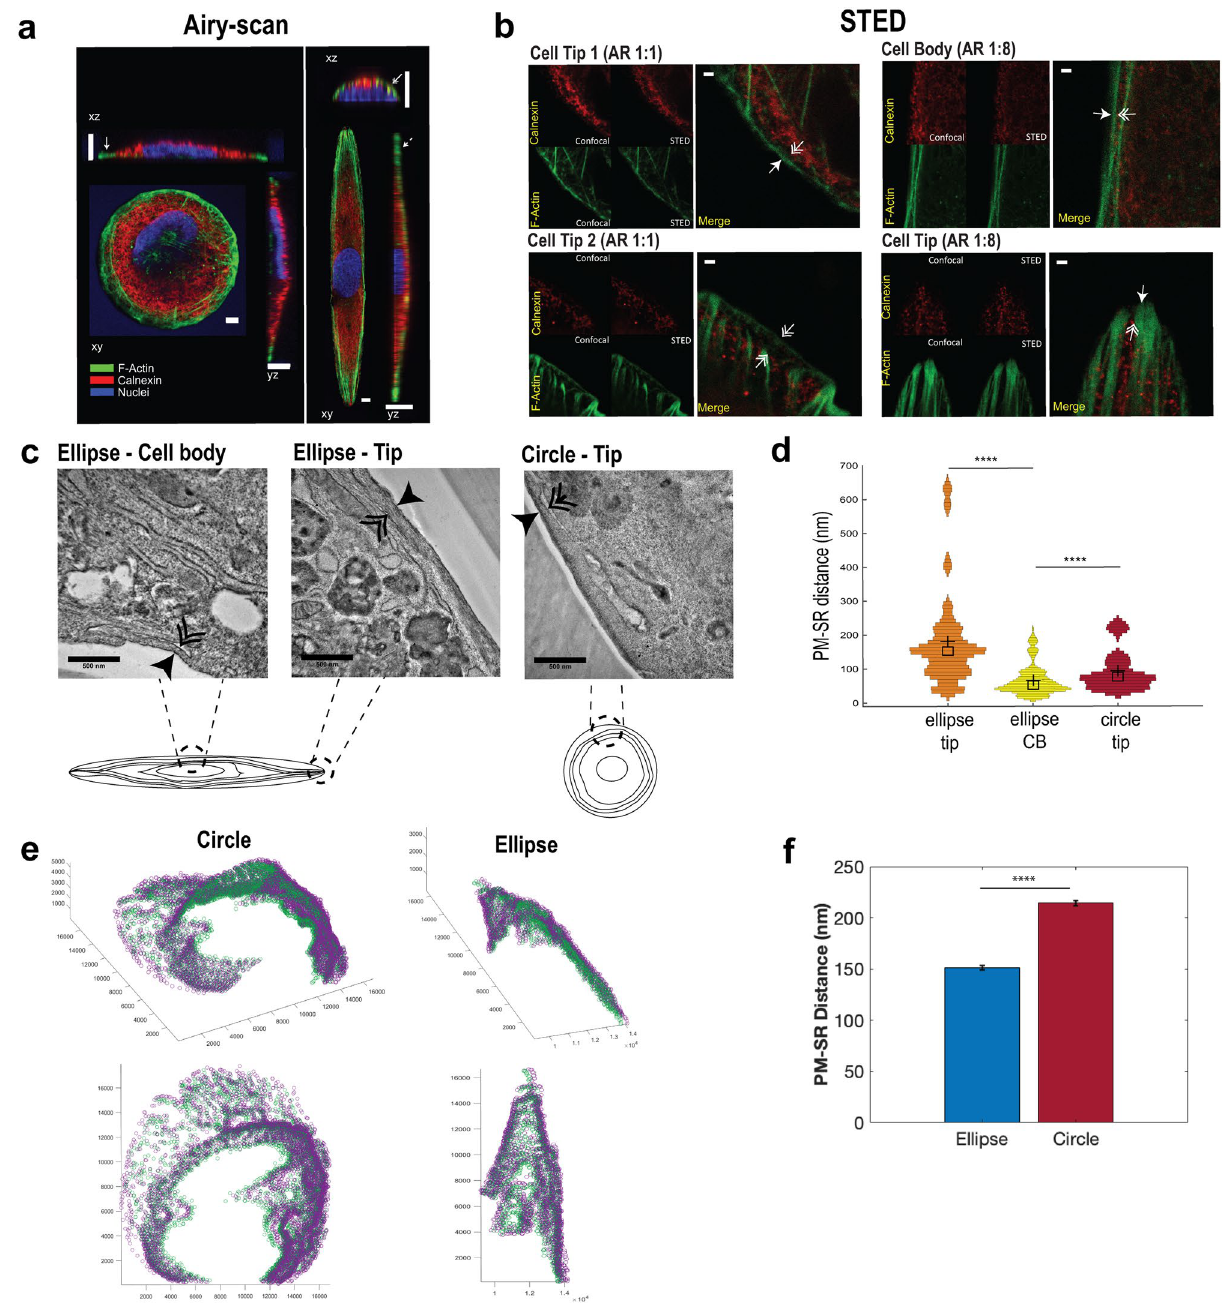
Figure 4. Shape impacts PM–SR distances in 3D. ( a ) (Left panel) 3D confocal volume scans of VSMC cultured in circle and ellipse (Aspect ratio of 1:8) patterns showing F-Actin (green), ER membrane marker calnexin (red) and nuclei (blue). Increased co-localization of red and green pixels are seen in the xz (short axis) cross-section of elliptical cells (solid double arrow heads), while little co-localization is evident in tips of both circular and elliptical cells (solid single-arrow heads and dashed single-arrow heads, respectively). Scale bars shown are 10 µm. ( b ) (Right panel) Super-resolution STED imaging of F-actin (green), calnexin (red), in cell tips of circular cells (AR 1:1) and in cell tip and cell body of elliptical cells (AR 1:8). Scale bars shown are 1 µm. ( c ) Representative TEM micrographs sampled from corresponding regions in micropatterned cells (cartoon). Single-headed arrows indicate the plasma membrane and double-arrows indicate smooth, peripheral SR, apposed to the plasma membrane. Scale bars shown are 500 nm. ( d ) Distribution plots of PM–SR distances obtained from TEM images, mean and median are shown as crosses and squares respectively. ( N ellipse tip = 329, N cell body = 254, N circle tip = 115, **** p < 0.0001, two-tailed Mann–Whitney test). ( e ) In order to quantify the 3D distribution of PM–SR distances, spatial dyads were manually segmented in each axial image for representative circular and elliptical cells. Green points represent the SR segments while purple points represent the PM. ( f ) The average PM–SR distance and standard error mean (SEM) for a representative circular and elliptical cell was computed from the 3D serial block face scanning electron microscopy images (N ellipse = 1692, N circle = 5309, N refers to PM–SR distances taken within the representative cells, **** p < 0.0001, two sample